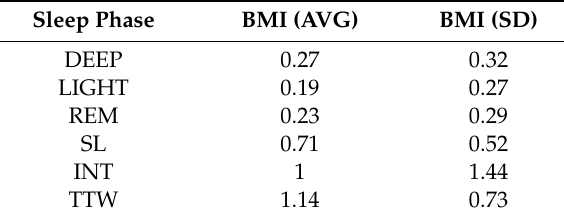
Table 2. Average (AVG) and standard deviation (SD) of the BMI obtained for each phase.